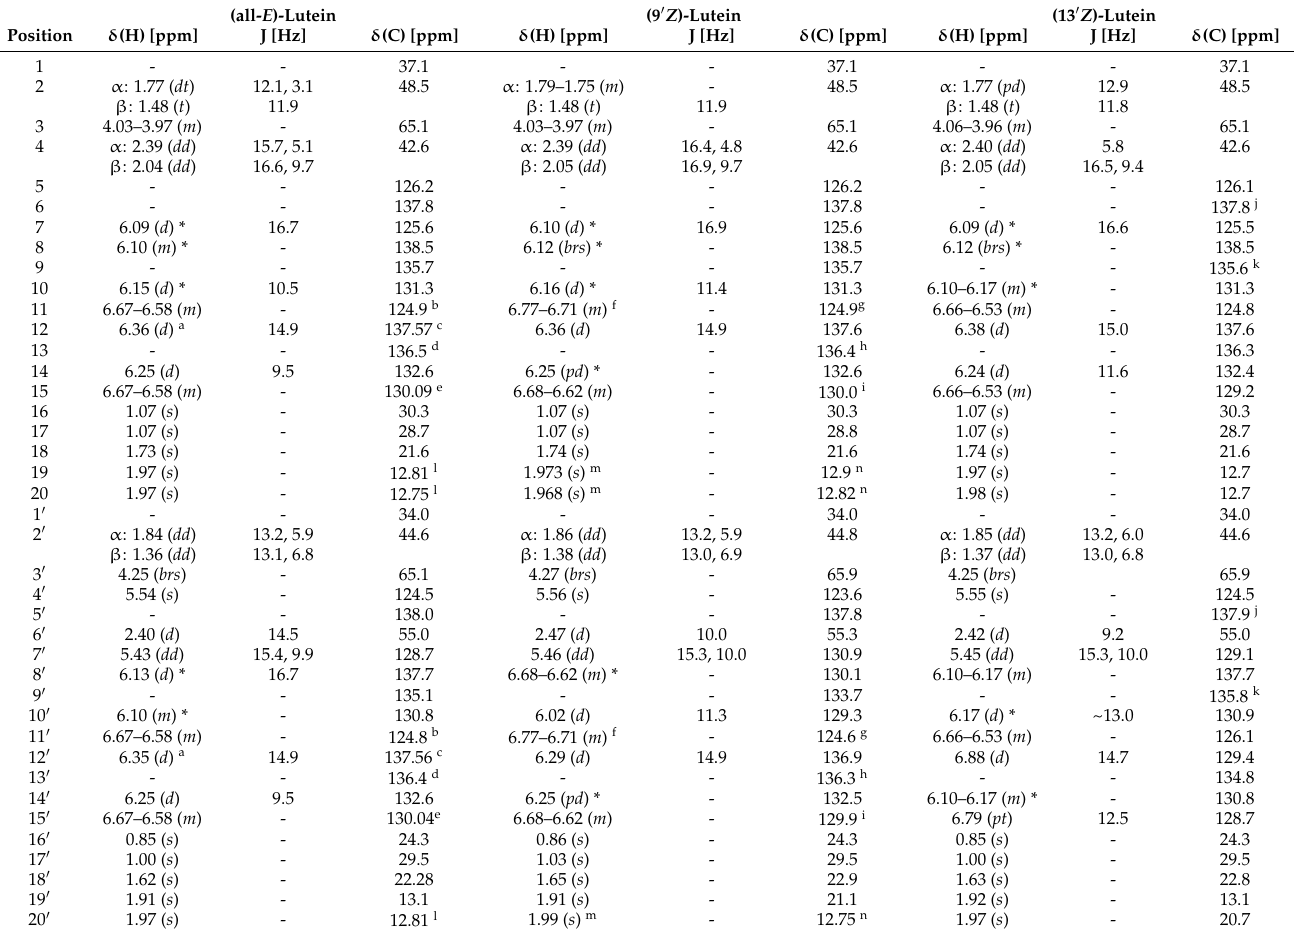
Table 1. 1 H- and 13 C-NMR data of (all- E )-, (9 (cid:48) Z )-, and (13 (cid:48) Z )-lutein at 500/125 MHz, respectively, in CDCl 3 at room temperature. All 1 H and 13 C spectra were assigned with the help of 1 H- 1 H-COSY, 13 C- 1 H-HSQC, and 13 C- 1 H-HMBC